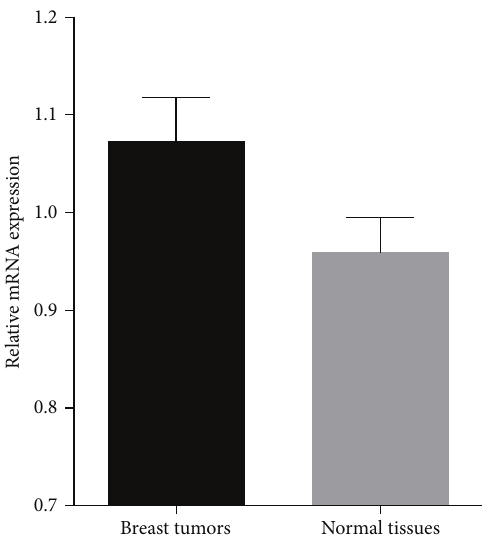
Figure 2: Relative mRNA expression of RGC32 in breast cancerous and noncancerous adjacent